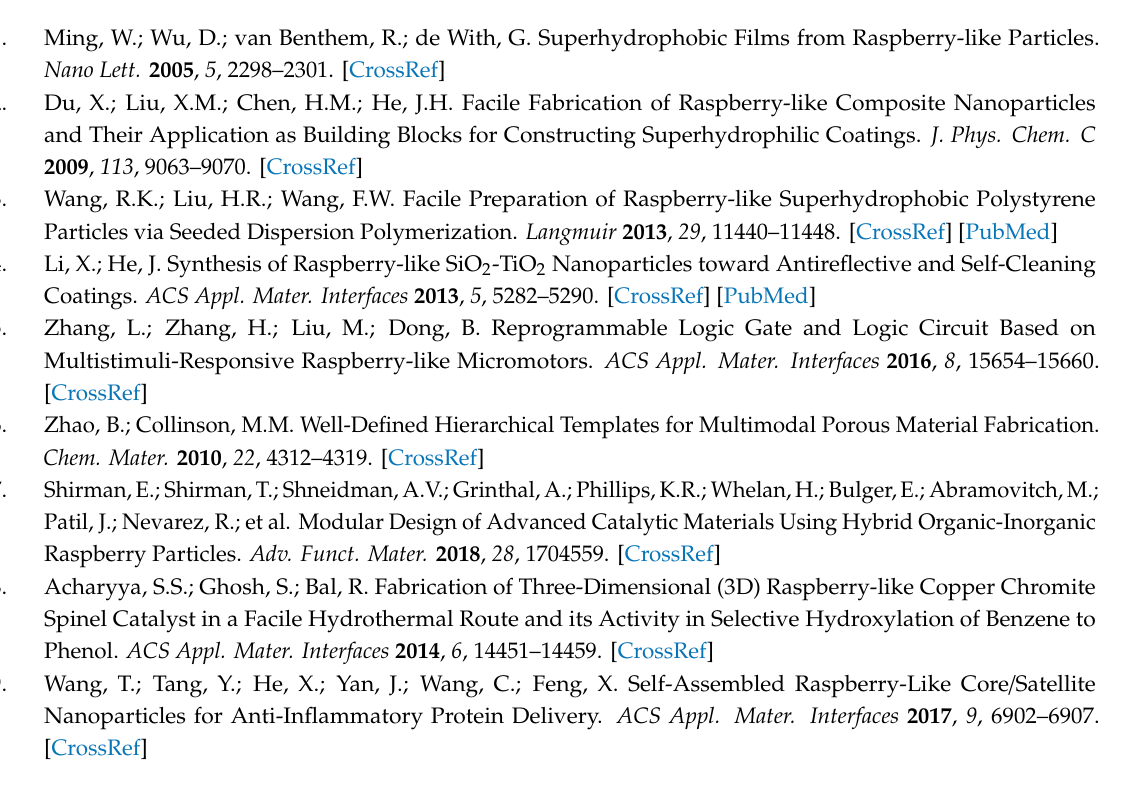
Figure S1: The scatterplots of size distribution of AuNC and AuNRbs during di ff erent growth stages corresponding to Figure 2(a–e). Figure S2: The TEM images of AuNRb-15 (a) when freshly prepared and (b) after a storage of four months. Figure S3: (a) A schematic diagram illustrating the aggregative growth of gold nanoparticles on the surface of smooth silica (S-SiO 2 ) nanoparticles. TEM images of (b) S-SiO 2 nanoparticles; (c) an S-SiO 2 nanoparticle attached by gold nanoseeds; and (d) S-SiO 2 template-based gold nanoshell. TEM images of gold products synthesized by (e) S-SiO 2 and (f) V-SiO 2 nanoparticles after the removal of templates. Figure S4: A TEM image of AuNP-20 prepared by sodium citrate reduction. Figure S5: The y-component of the time-averaged power flow of relative field at the wavelength of (a) 760 nm and (b) 565 nm when the interparticle distance is 4 nm and the nanoparticle size is 16 nm in diameter. The y-component of the time-averaged power flow of relative field at the wavelength of (c) 730 nm and (d) 615 nm when the interparticle distance is 0.9 nm and the nanoparticle size is 10 nm in diameter. The total power dissipation density when (e) the interparticle distance is 5.2 nm at the wavelength of 520 nm, and when (f) the interparticle distance is 0.9 nm at the wavelength of 600